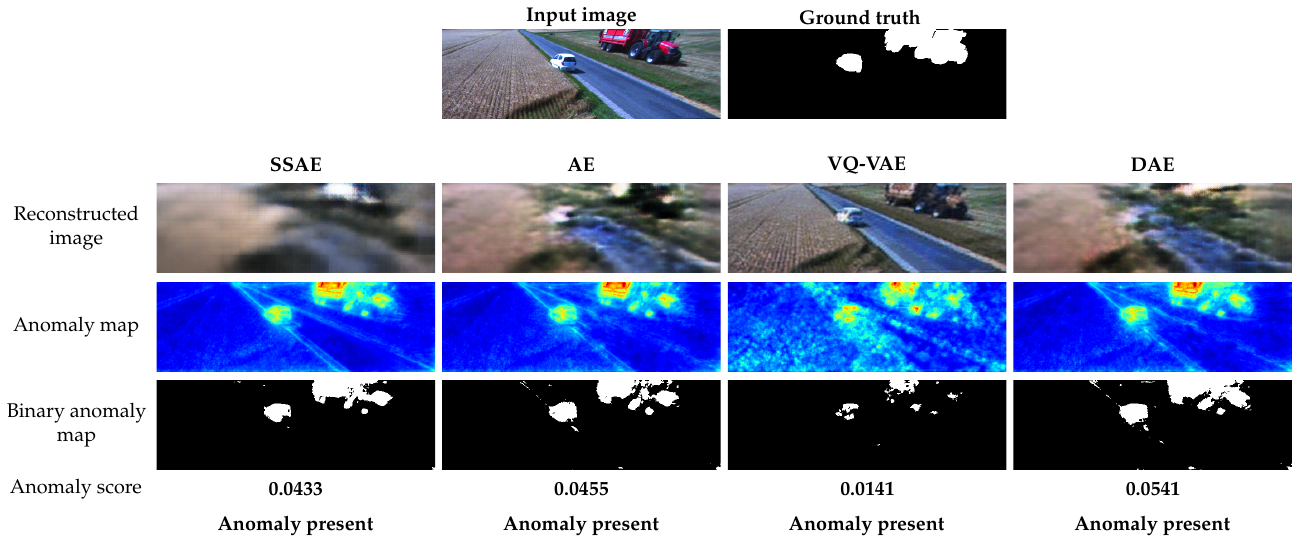
Figure 6. Anomaly detection example for autoencoders. The example input image shows a tractor with a trailer and a car in the field. The anomaly maps are generated by relative-perceptual-L1 loss and thresholded for each autoencoder to obtain a binary anomaly map. The calculated anomaly scores are above thresholds and the image is correctly classified as anomalous.